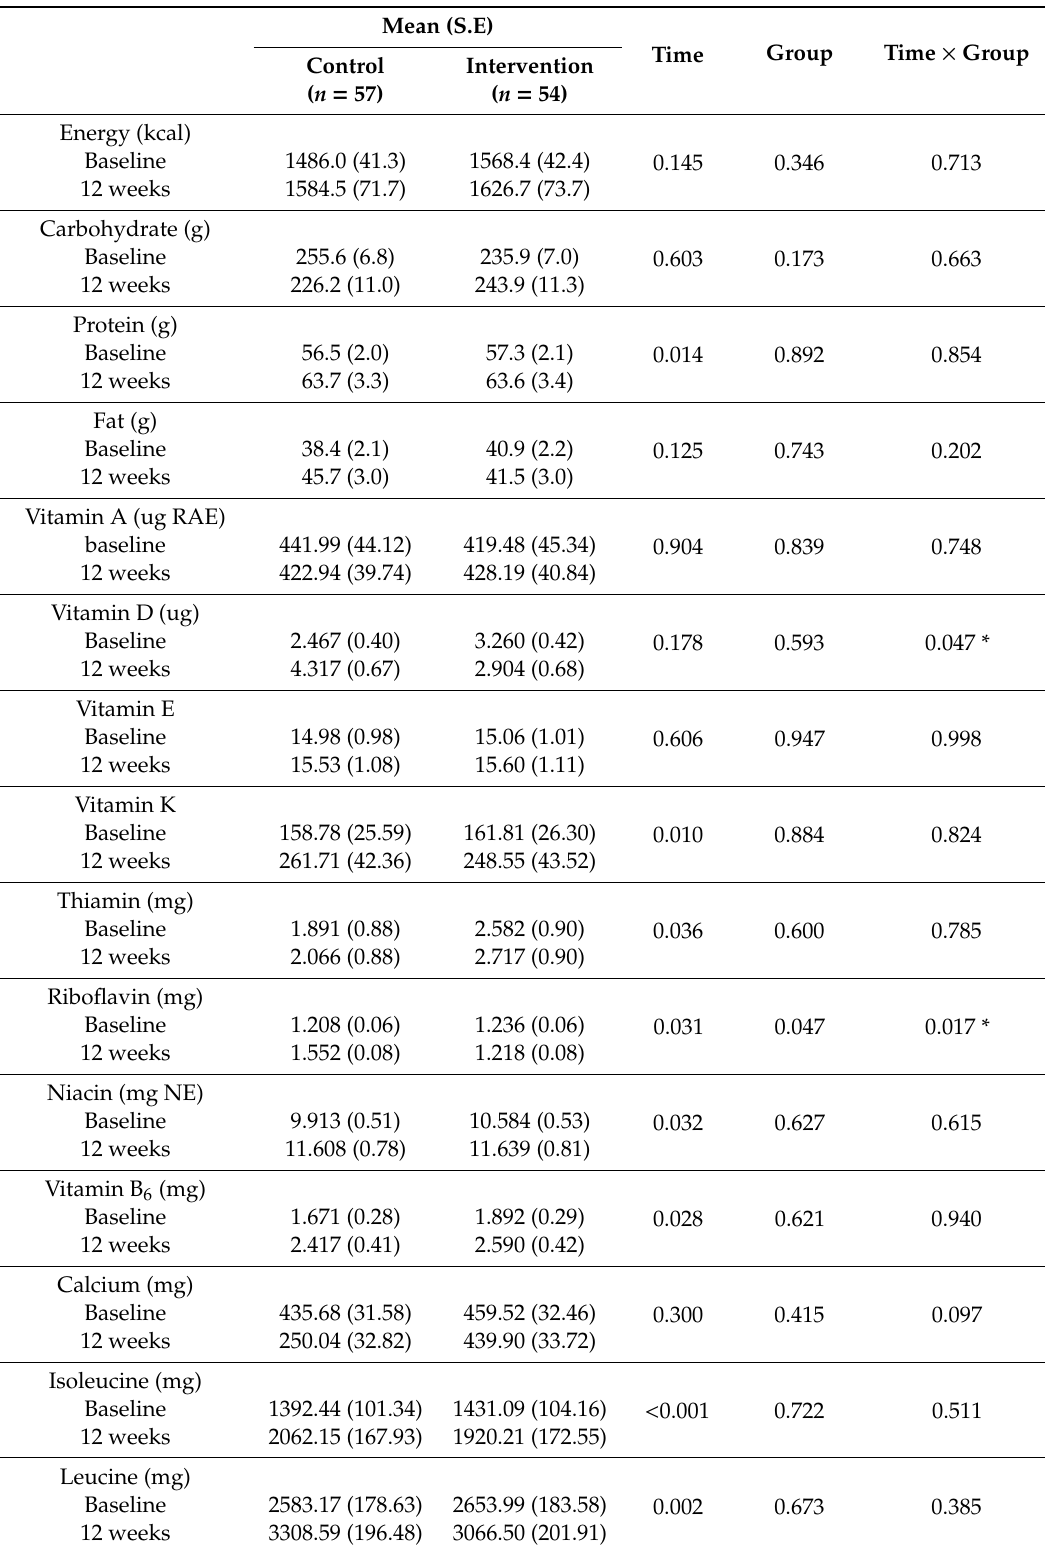
Table 2. Changes of dietary intake during the 12-week